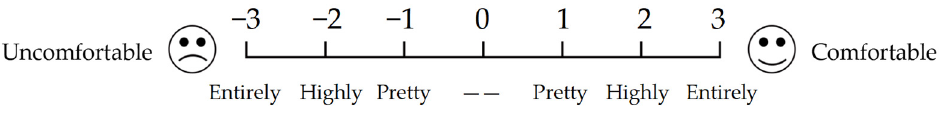
Figure 4. Semantic difference scale for comfort rating scale.